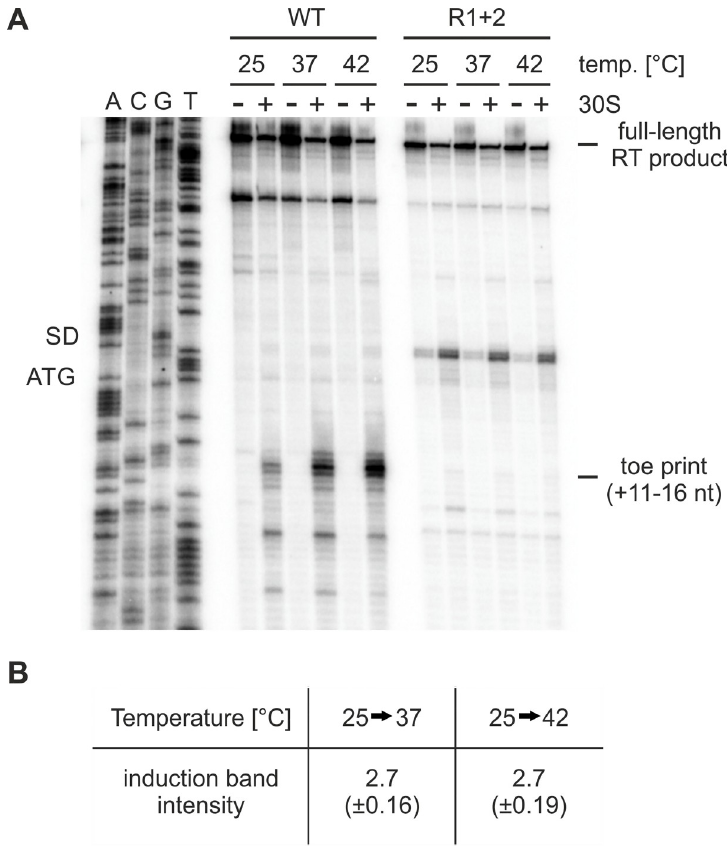
Fig 7. Temperature-controlled ribosome binding to the cnfY RNAT. (A) Primer extension inhibition of the wild type (pBO4465) and R1+2 cnfY RNAT (pBO4466) in presence (+) or absence ( − ) of 30S ribosomal subunits was conducted as described in material and methods. The resulting signals correspond to the full-length reverse transcription (RT) product and the termination product (toe print; corresponding to nucleotides +11 to +16 from AUG). ACGT indicate the corresponding DNA sequencing reactions. The SD sequence as well as the ATG codon are labelled. The experiment was performed at least in triplicate (three biological replicates). (B) Toe printing signals (nucleotides +11 to +16 from AUG codon) were quantified by integrated density quantification using AlphaEaseFC software. The mean density ratio (25˚C/37˚C) and its standard deviation was calculated from three independent